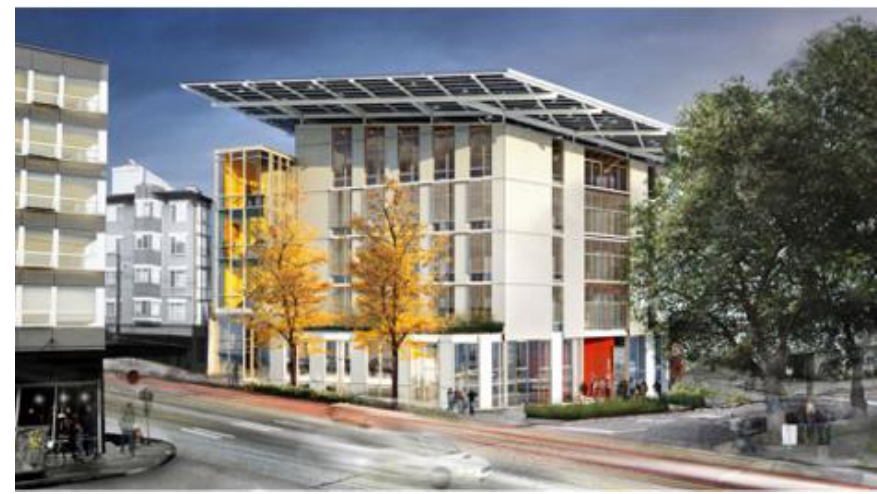
Figure 15. The Bullitt Center, designed to be the greenest commercial building in the world, qualified as a “Living Building” by the International Living Future Institute [38].